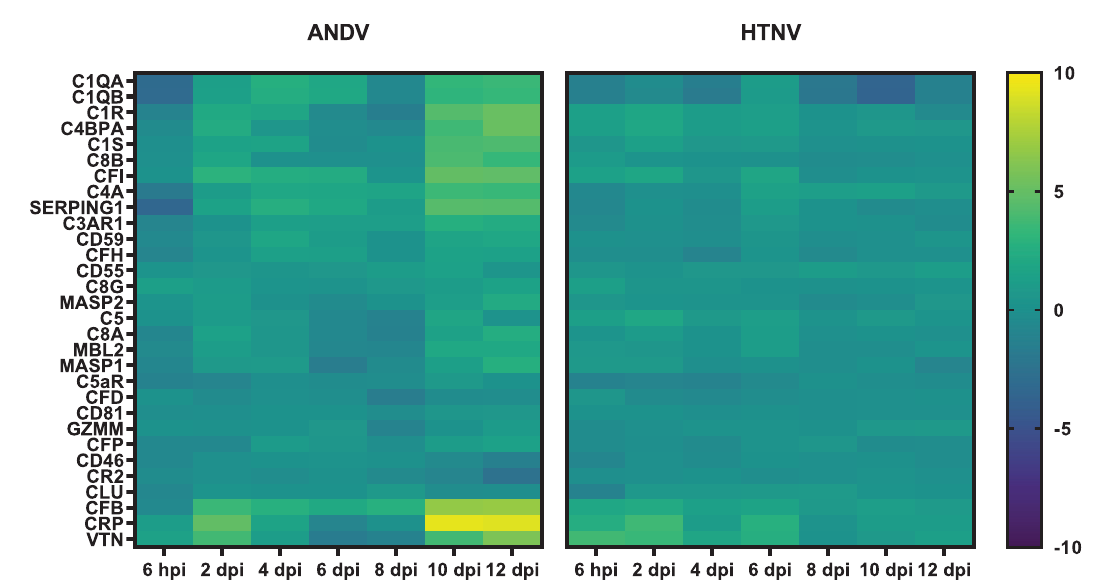
Fig 7. Complement Pathway Expression in Hantavirus Infected Hamsters. Genes associated with complement expression are displayed as a heat map with hierarchical clustering and intensity of the colors corresponding to the magnitude of fold change over the baseline.